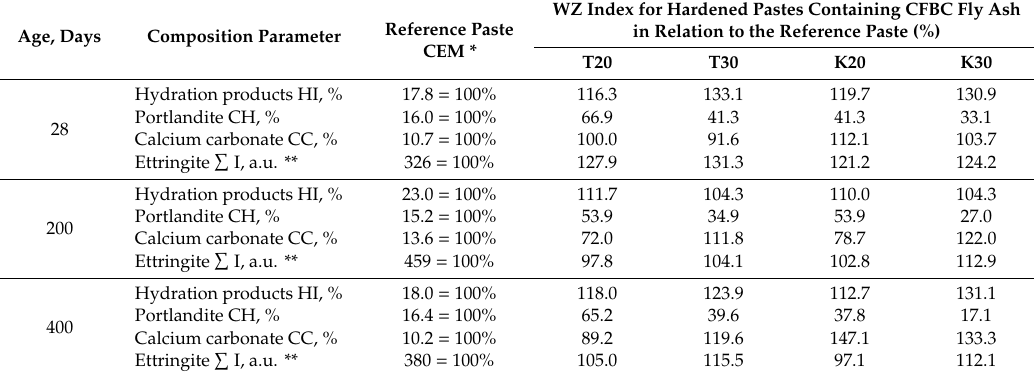
Table 7. XRD estimated composition of hardened cement paste after 28, 200 and 400 days of curing (CFBC T—paste with fly ash from lignite burning. CFBC K—paste with fly ash from hard coal burning. 20 / 30–percent content of fly ash